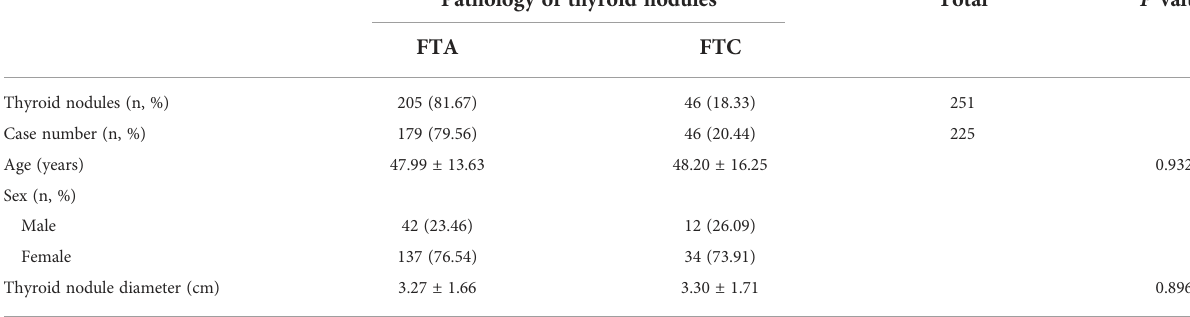
TABLE 1 Baseline characteristics of FTA and FTC